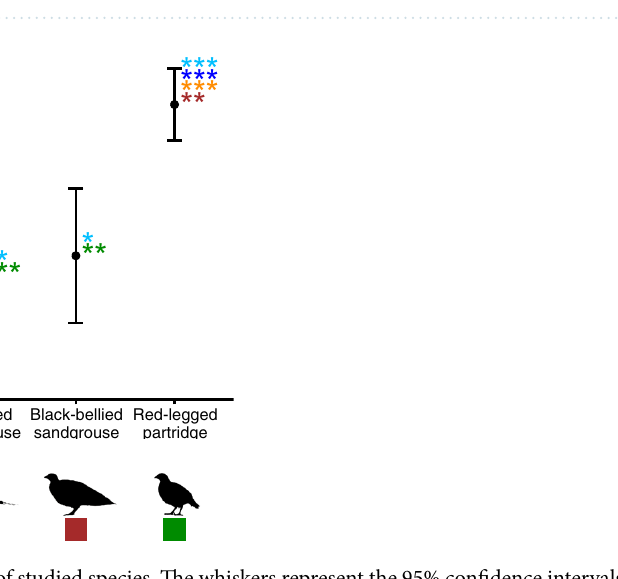
Figure 2. Mean percentage of reads (a measure of abundance) and OTUs (a measure of richness) of the Chloroplastida, Arthropoda, Mollusca, and Annelida taxa present on the diet of studied farmland bird species. Percentages > 10% are specified numerically and in the case of reads, SD is indicated in brackets. In the OTUs graphs, OTUs richness is also indicated. Note that samples of great bustard, little bustard, pin-tailed sandgrouse, black-bellied sandgrouse, and red-legged partridges were collected during the non-breeding season, whereas samples of common quail were collected during the breeding season.